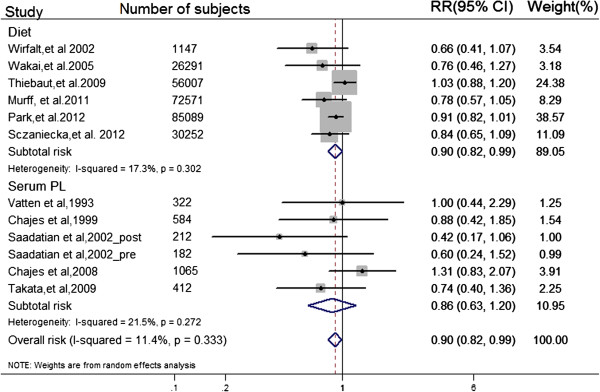
Forest plot of ratio of n-3/n-6 PUFAs in diet or serum PL for the highest vs. lowest. Prospective studies concerning dietary and serum PL ratio of n-3/n-6 PUFAs separately are referred to by first author, year of publication and number of subjects, weighted and ranked according to the inverse of the variance of the logRR estimate. The relative risks (RRs) are represented by the squares (the size is proportional to the weights used in the meta-analysis), and CIs are represented by the error bars. P values for heterogeneity test (I square and Q test) and RR for the highest exposure quantile vs. lowest from individual study were pooled by using random effect model. The diamonds can represent the pooled RR from subtotal risk estimate of dietary or serum PL ratio, according to their corresponding position in the figure.